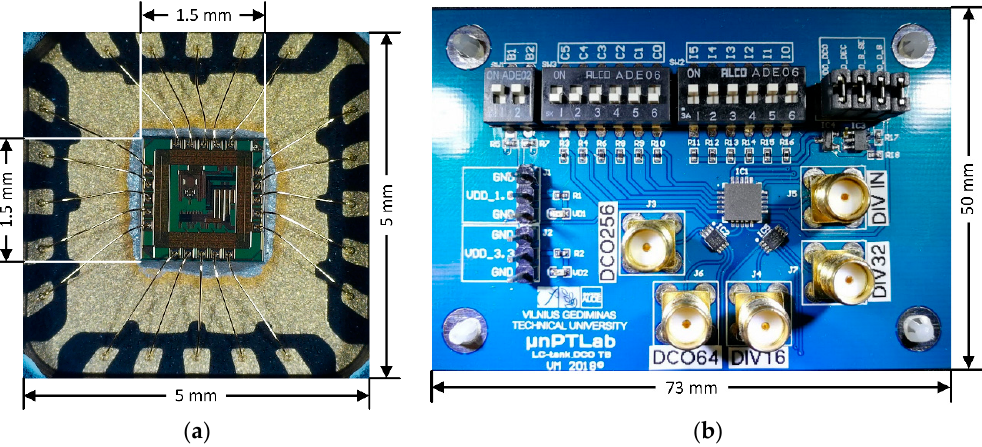
Figure 10. LC DCO and frequency divider IC: ( a ) in quad flat no-leads (QFN) with 20 pads package, and ( b ) in printed circuit test board (PCB).